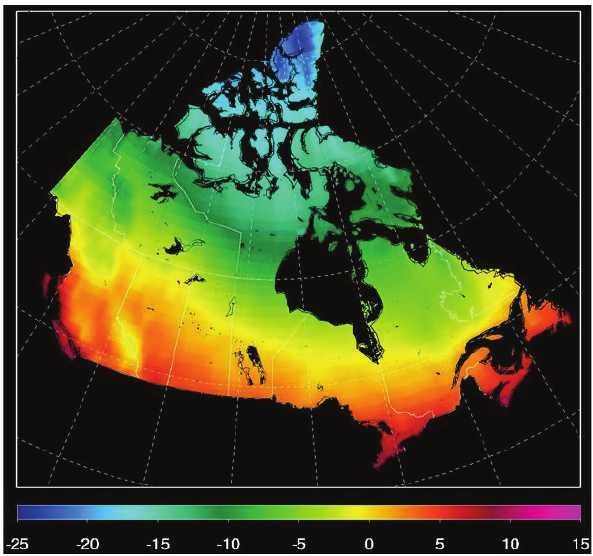
Fig. 7. Spatial distribution of mean annual air temperature ( ◦ C) over Canada’s landmass during the 30yr of 1979–2008.